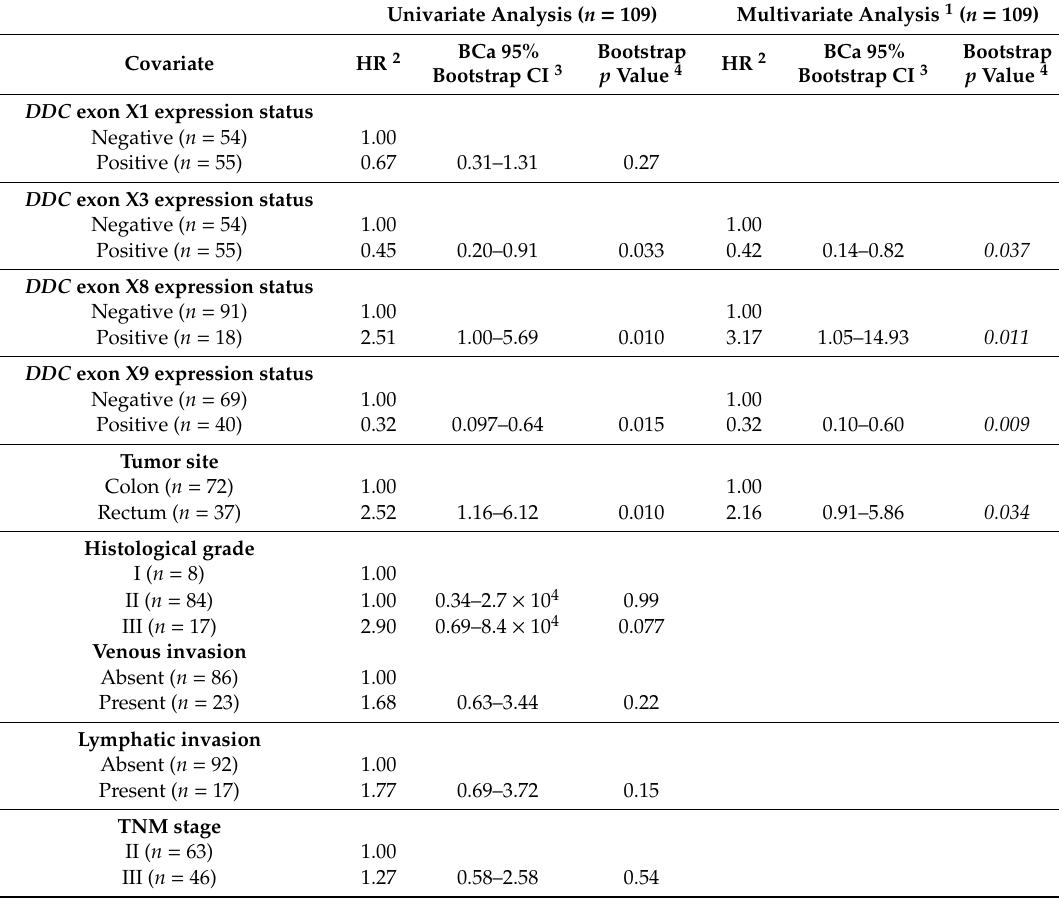
Table 3. Expression status of DDC novel exons and DFS of CRC